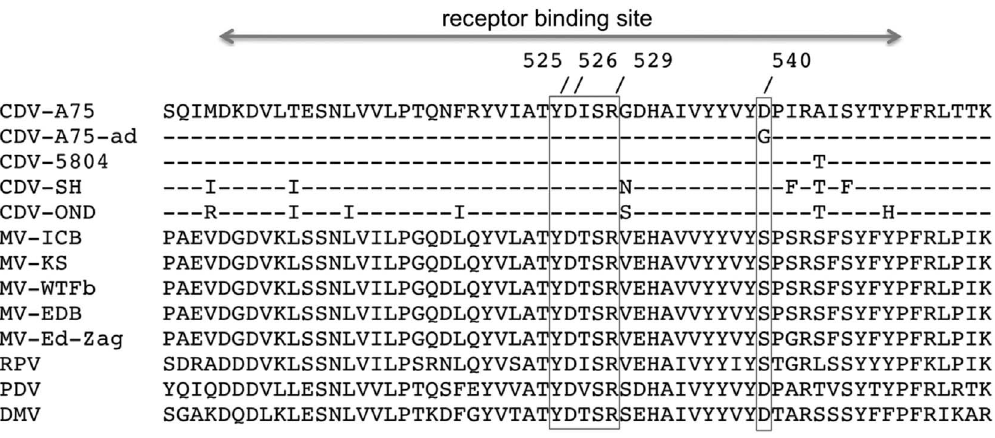
Figure 5. Comparison of the CD150 binding sites of Morbillivirus H proteins. The receptor (CD150) binding site of the Morbillivirus H- proteins comprises approximately amino acid 500 to 550. CDV-H position 540 (corresponding to MV-H position 544) is located nearby the cognate receptor interacting residues 525, 526, and 529 [25]. CDV-A75-ad=human CD150-adapted CDV-A75/17 red .